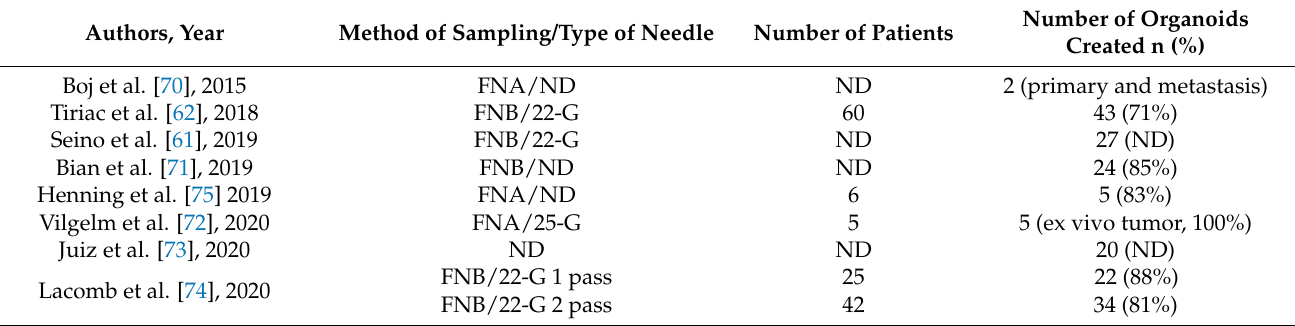
Table 2. Culture of patient-derived